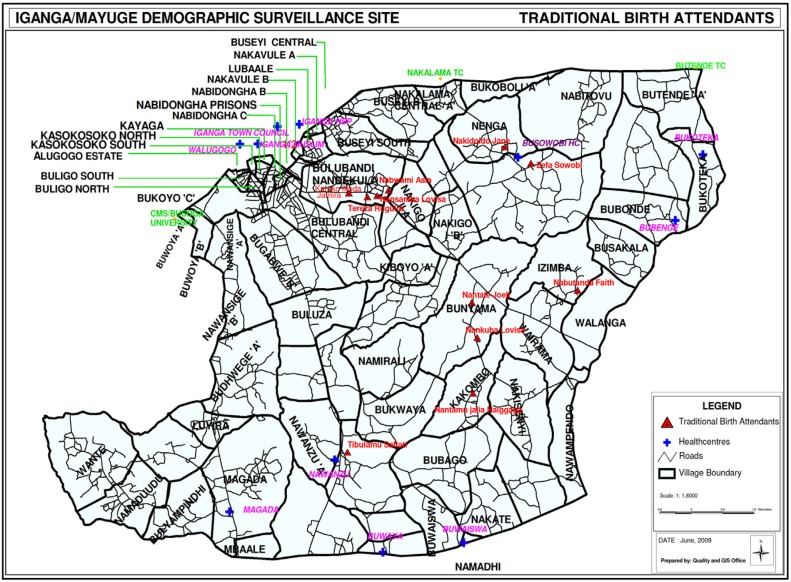
Map of the UNEST study area.